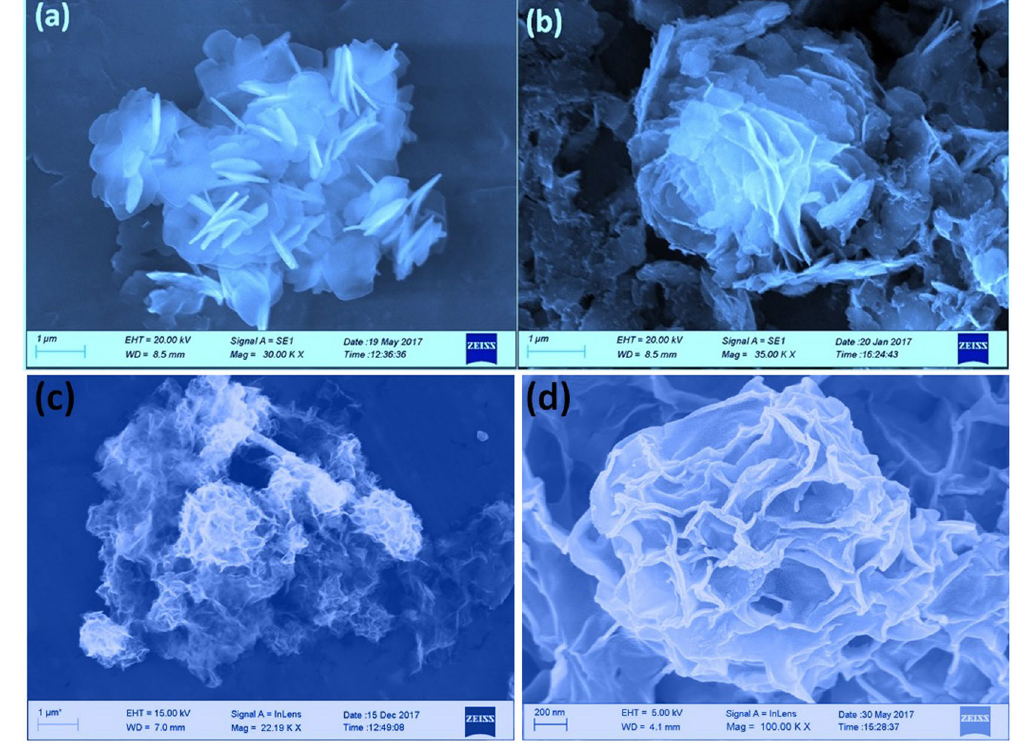
Figure 6. FE-SEM analysis of ( a , b ) Cu 3 (PO 4 ) 2 -PEG synthesized by solid state reaction. ( c , d ) 8RGO-Cu 3 (PO 4 ) 2 - PEG synthesized by solid state reaction with directly adding RGO during the grinding